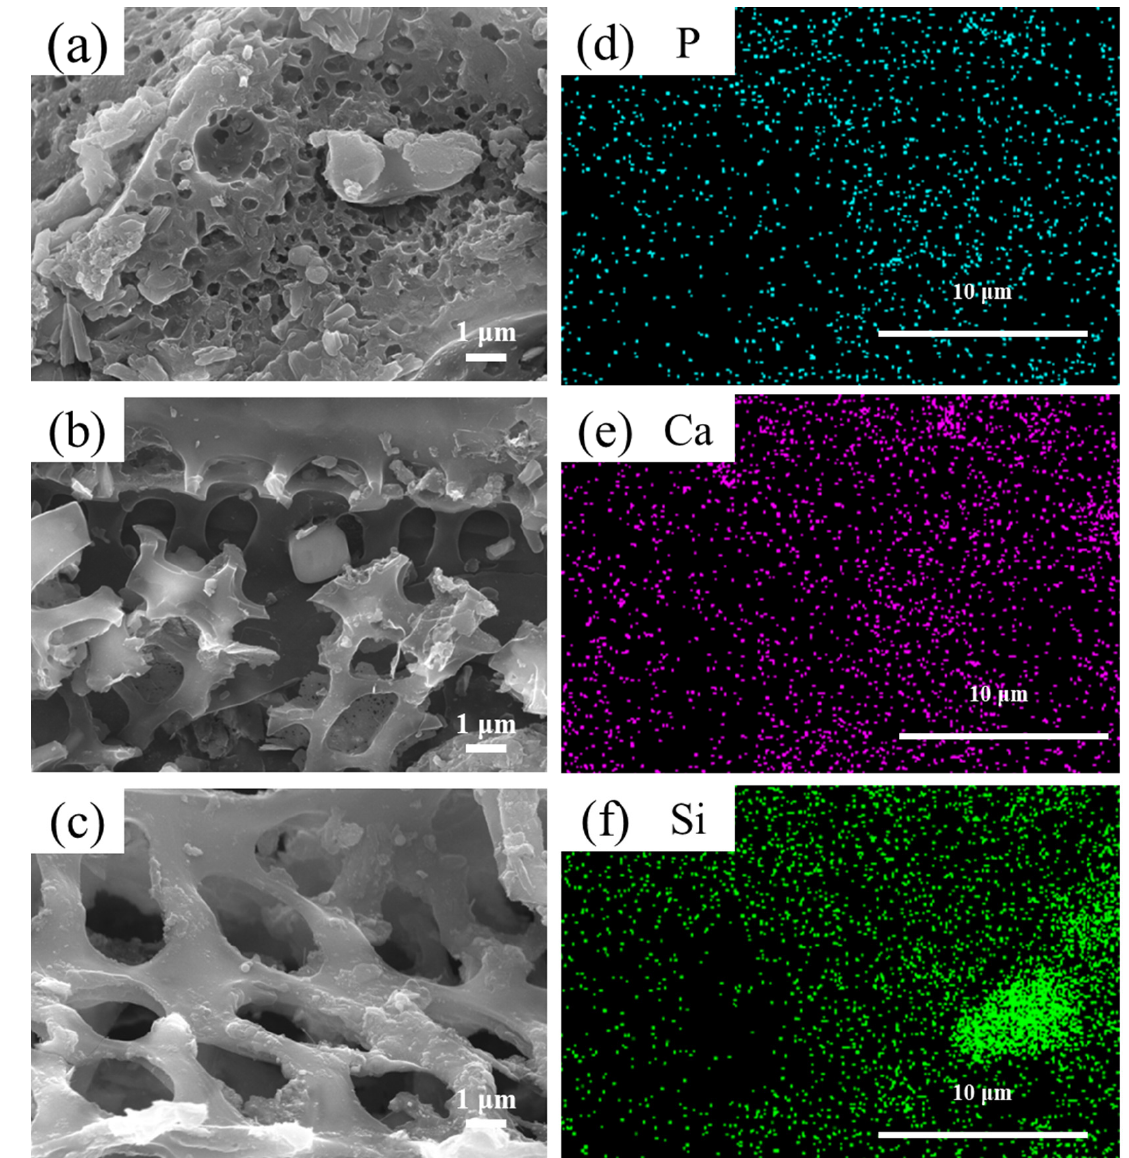
Figure 1. SEM and EDS images of CMBC ( a – c ): SEM images of CM400, CM600, and CM800; ( d–f ): EDS images for P, Ca, and Si of CM400.